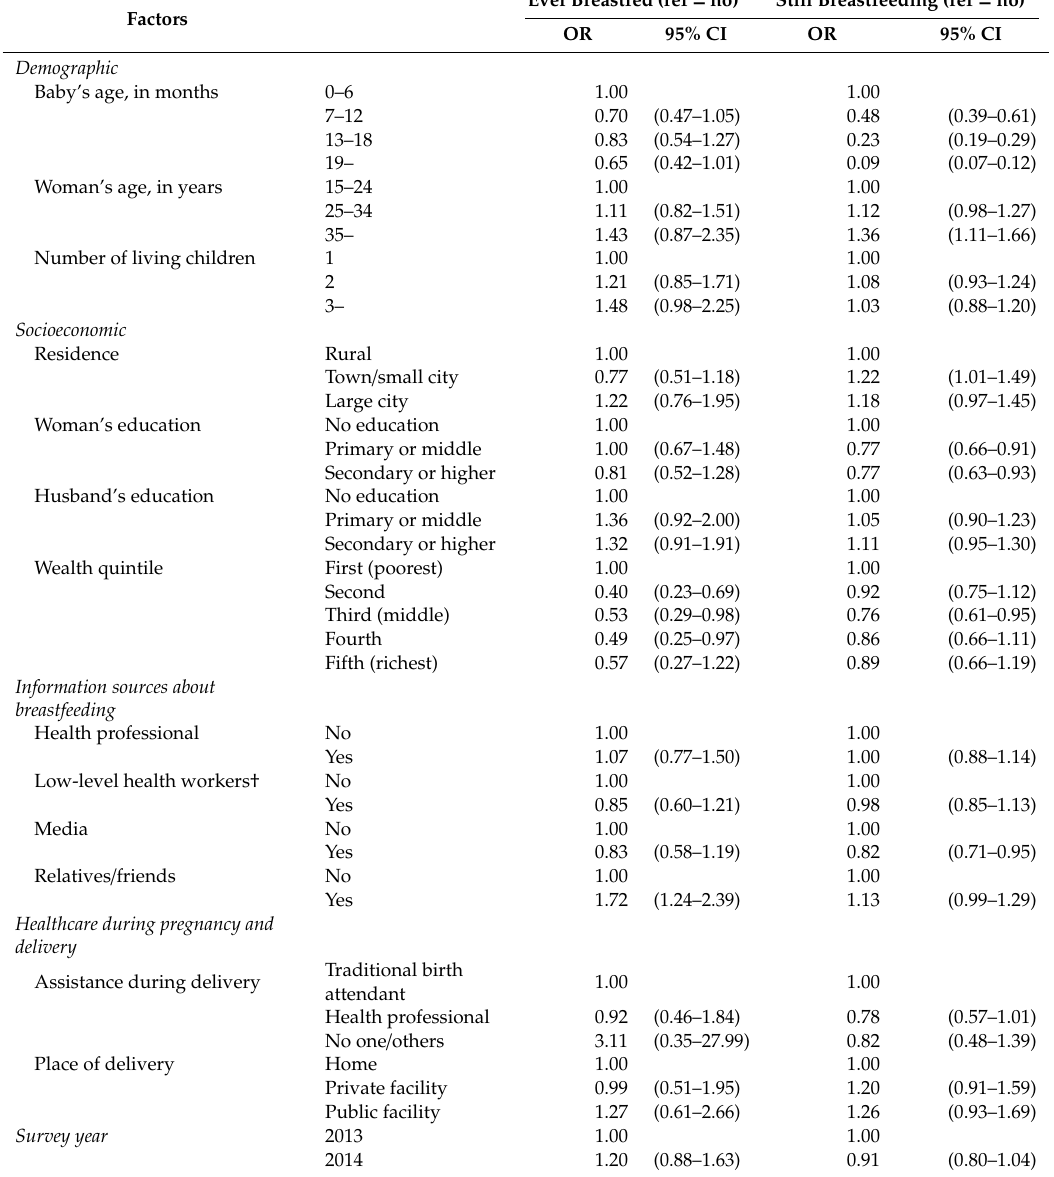
Table 2. Factors associated with breastfeeding status in multiple logistic